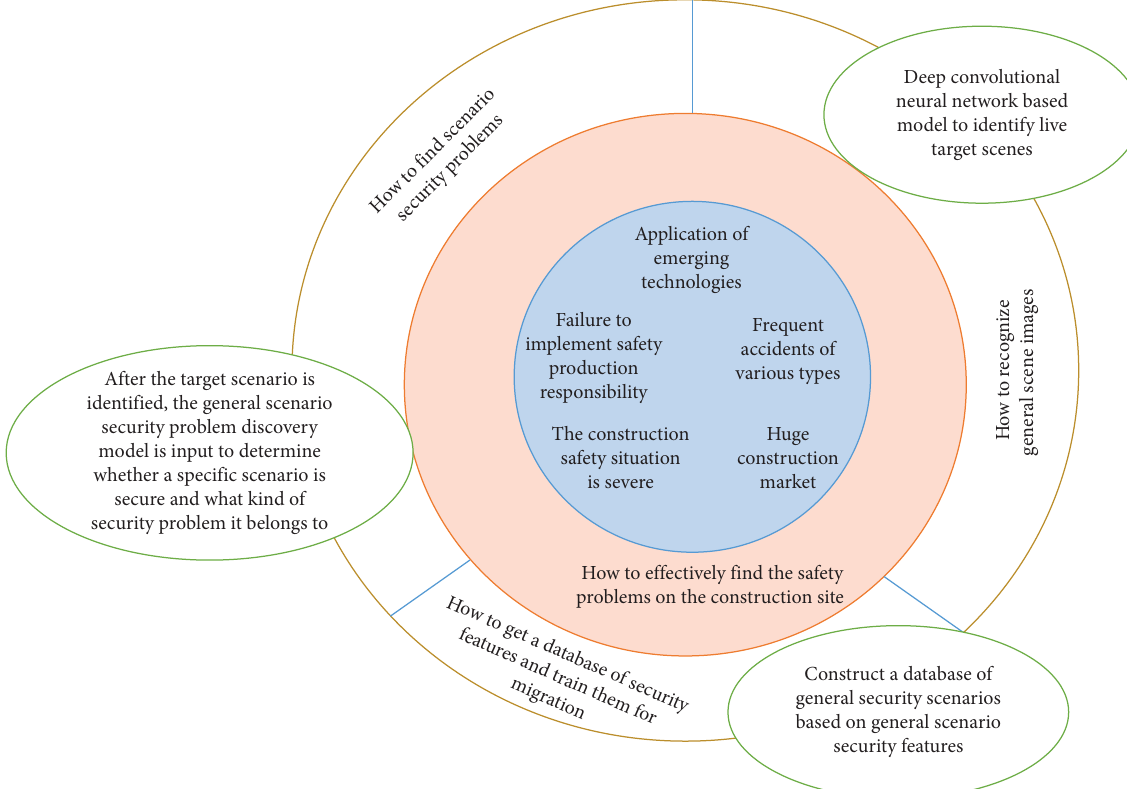
Figure 1: For the construction site safety problem detection and